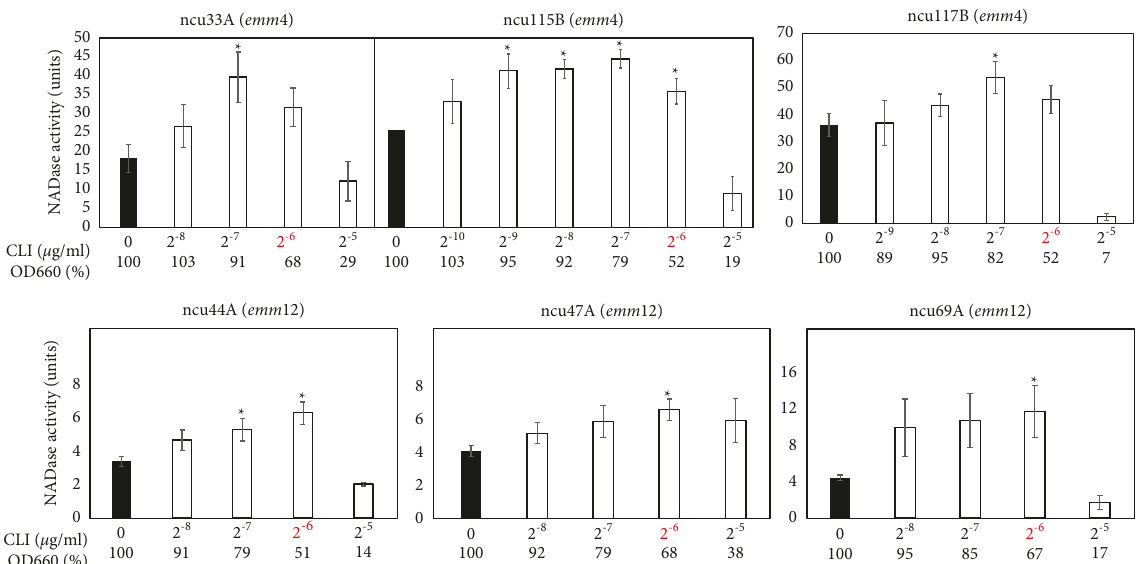
Figure 3: Extracellular NADase activity in emm 4-or emm 12-type strains cultured with CLI. NADase activity was determined based on the criteria described in Figure 1. The OD 660 of overnight culture with CLI (2 − 10 to 2 − 5 μ g/ml) is shown by a percentage (%) of that without CLI (0 μ g/ml). The maximum CLI concentration that did not suppress the bacterial growth to less than 50% of that without CLI is shown in red, which was 2 − 6 μ g/ml in all three strains. At least three independent experiments were performed. Error bars indicate the standard errors of the means. Significant increases in extracellular NADase activity by CLI treatment when compared with that without CLI treatment, which is shown by the black bar, are marked with asterisks ( ∗ p < 0 . 05 using Student’s t